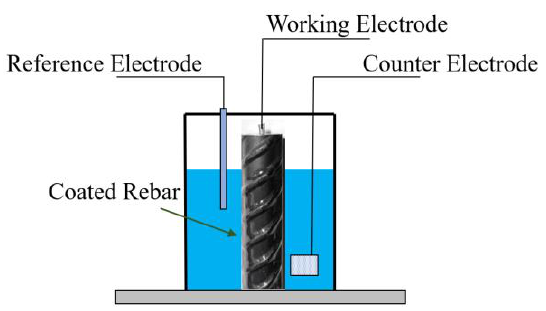
Figure 1. Setup of electrochemical impedance spectroscopy (EIS) test.